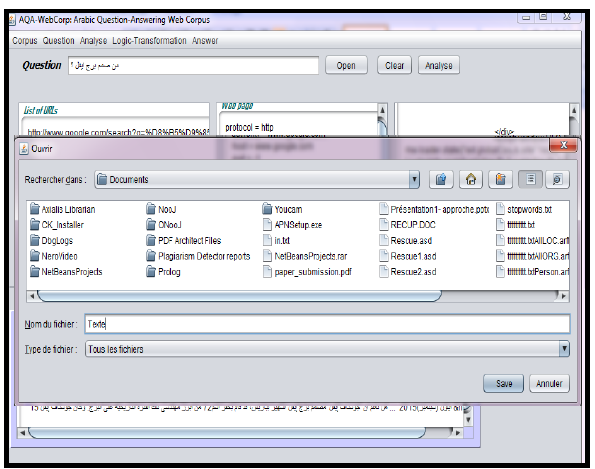
Figure 9. Saving the text